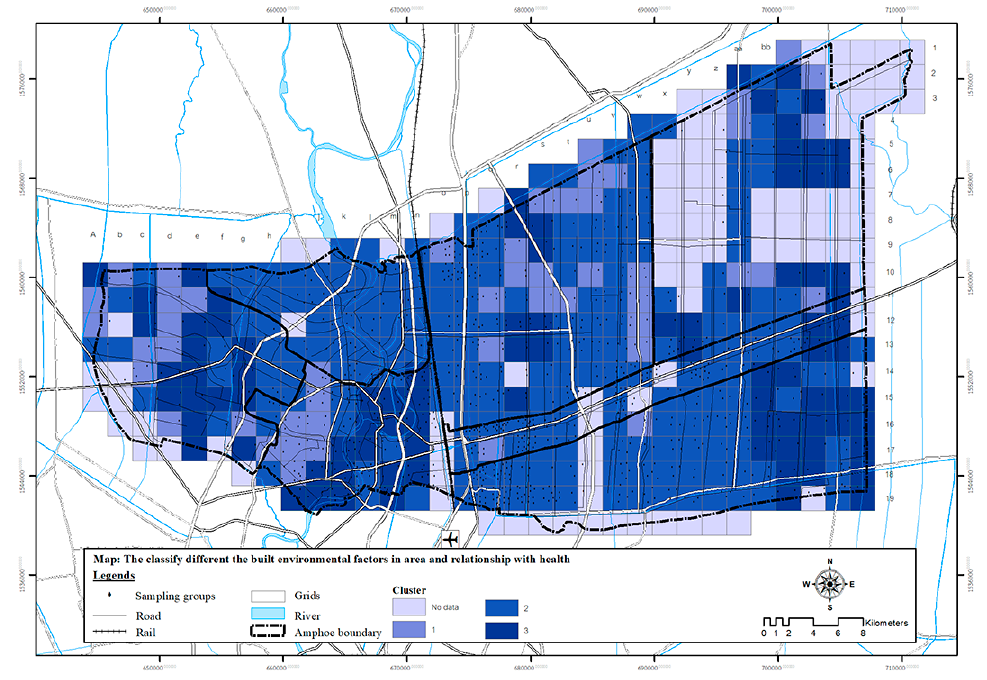
Figure 6. Clustering of different built environmental factors in the study